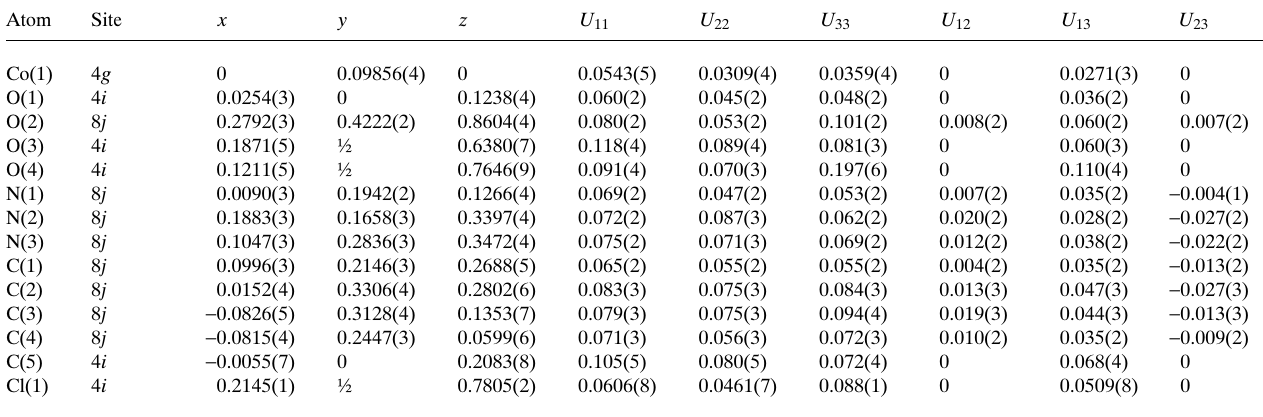
Table 3. Atomic coordinates and displacement parameters (in Å 2 )